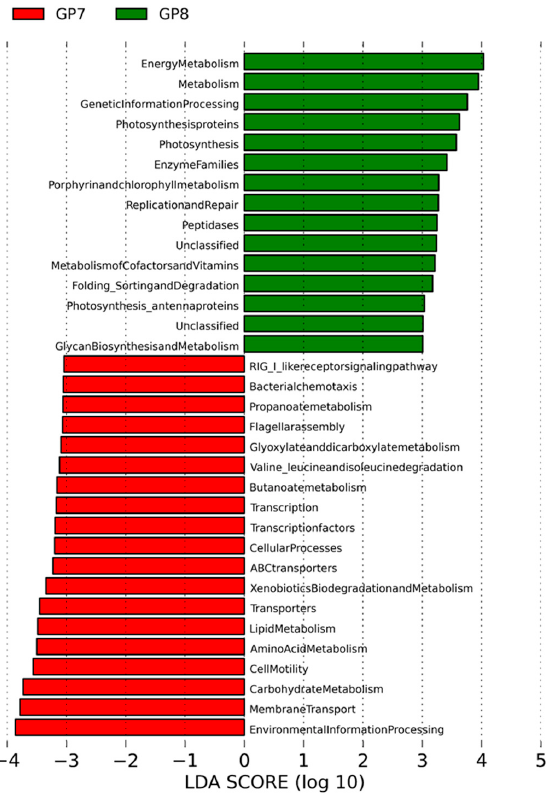
Figure 6. Genetic functional categories of genomic contents according to KEGG pathway analysis between two sites, with the list of categories indicating LDA scores > 3.